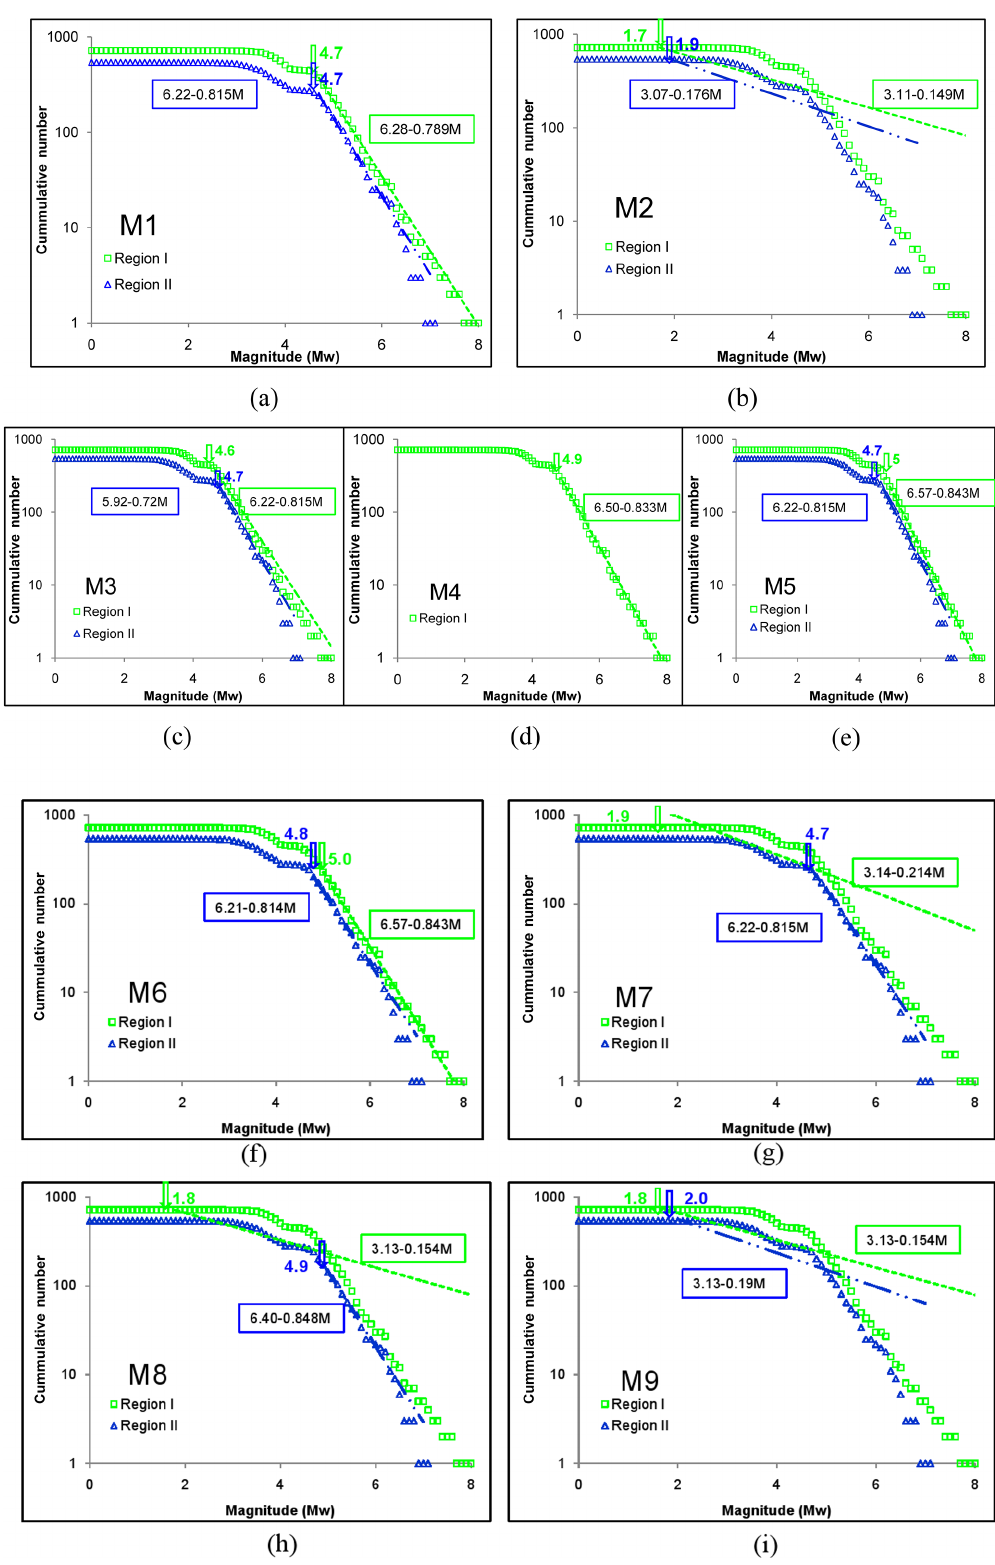
Figure 2. M c value along with a and b parameters for M1, M2, M3, M4, M5, M6, M7, M8, and M9 for region I (open square) and region II (open